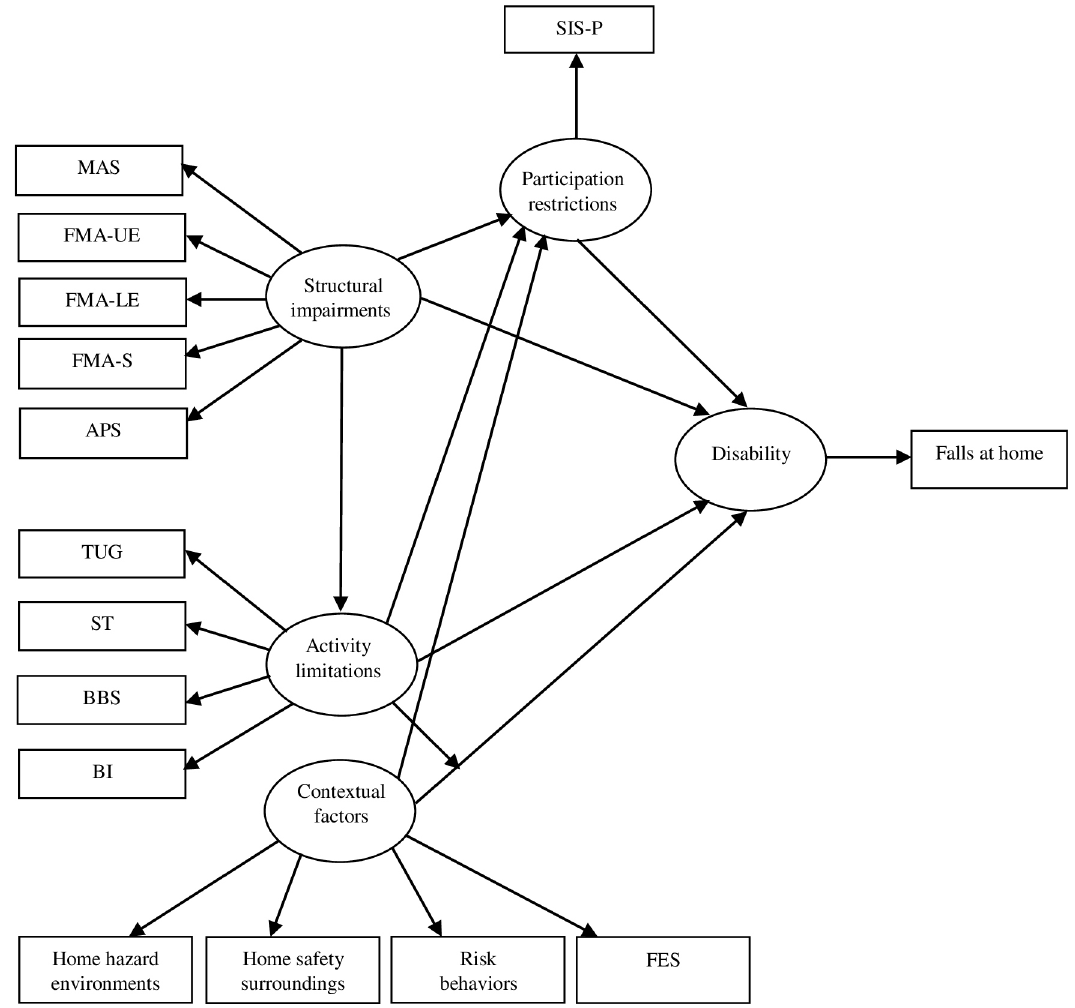
Fig 1. Hypothesis model for structural equational model